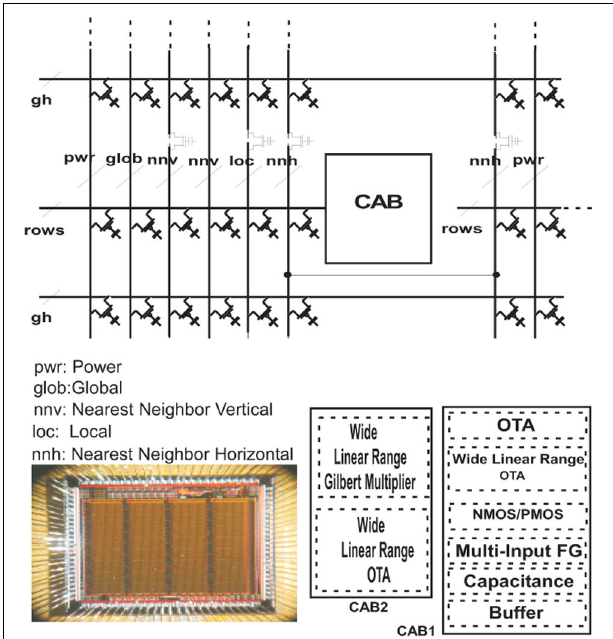
FIGURE 8 | Micrograph of the Reconfigurable Analog Signal Processor (RASP), also referred to the Field Programmable Analog Array (FPAA). The circuits were compiled onto this device. Computational Analog Blocks (CAB) populate the chip where both the computational elements and the routing is configured via floating gates. Buffers, capacitors, transmission gates, NMOS, PMOS, floating gates, current biases, adaptive amplifiers, and analog multiply arrays are all available and fully programmable on the chip. Development is shared by many in the CADSP group at Georgia Tech. FIGURE 9 | The typical routing structure and available analog